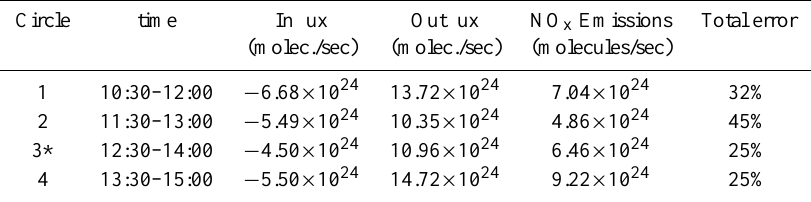
Table 3. NO x emissions from the encircled area after corrections for the lifetime and NO x partitioning. The total error includes the sun of all error contributions (retrieval of the tropospheric VCD, wind field, NO x lifetime, NO x partitioning).